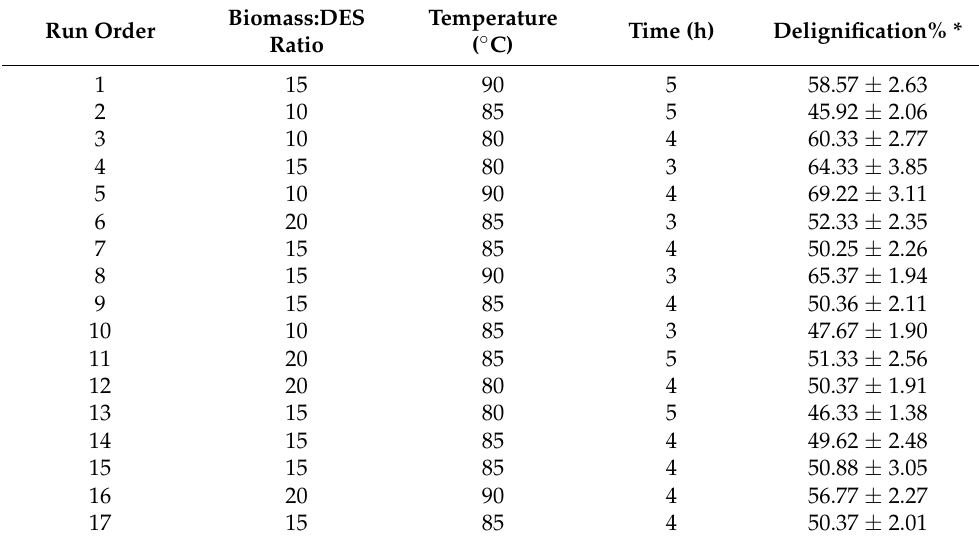
Table 2. BBD-based run of experiments for DES pretreatment and the observed delignification.